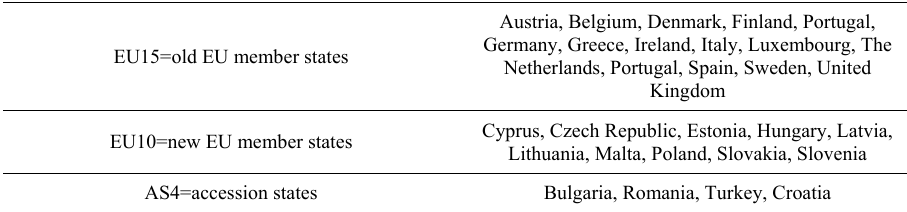
Table 2: Involved EU countries in